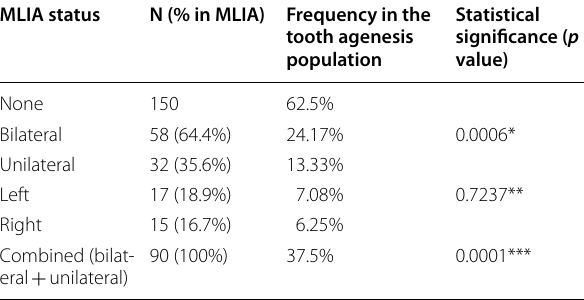
* Bilateral compared to unilateral; **comparing unilateral left to right; and